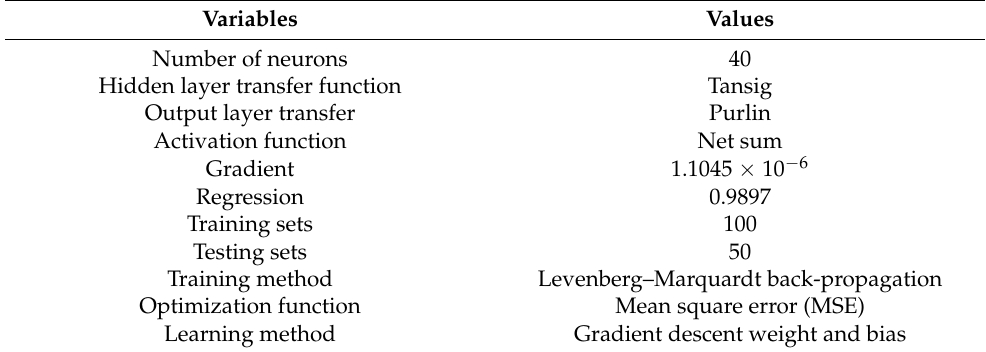
Table 3. ANN Parameters.